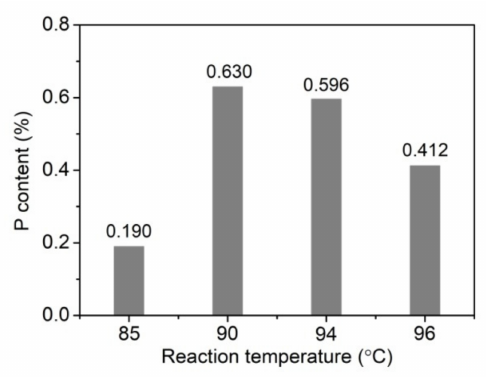
Figure 5. P content of PA-MCC obtained at various reaction